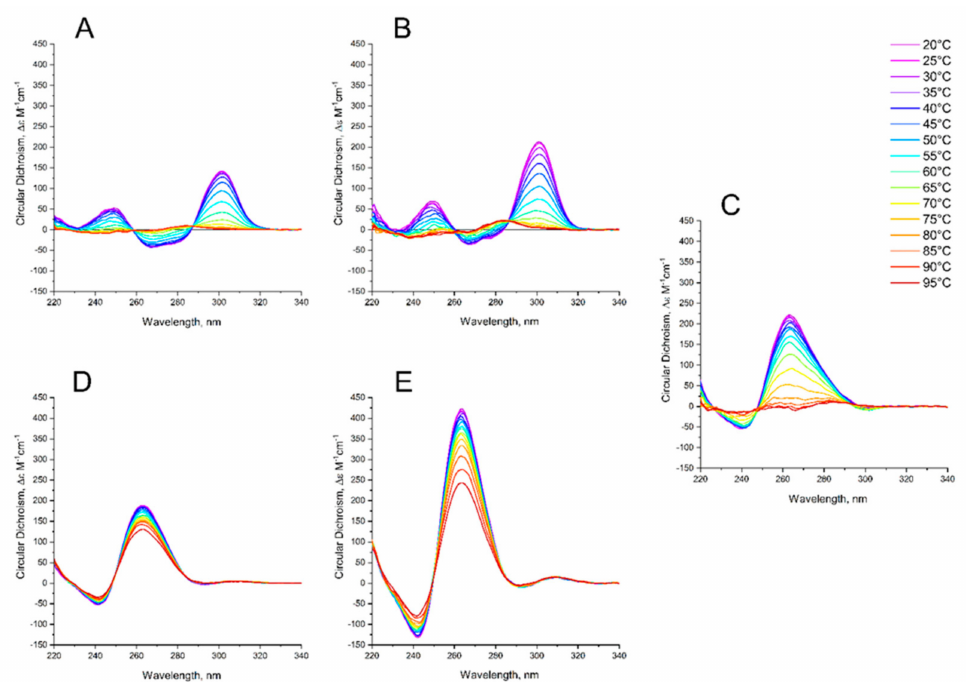
Figure A1. CD spectra of GQs under study in buffer C (140 mM NaCl, 10 mM KCl, 5 mM BaCl 2 ) at different temperatures: ( A ) HD1, ( B ) bi-HD1; ( C ) AS1411, ( D ) AID-1-T, ( E ) bi-(AID-1-T). The color ladder on the right indicates temperatures.